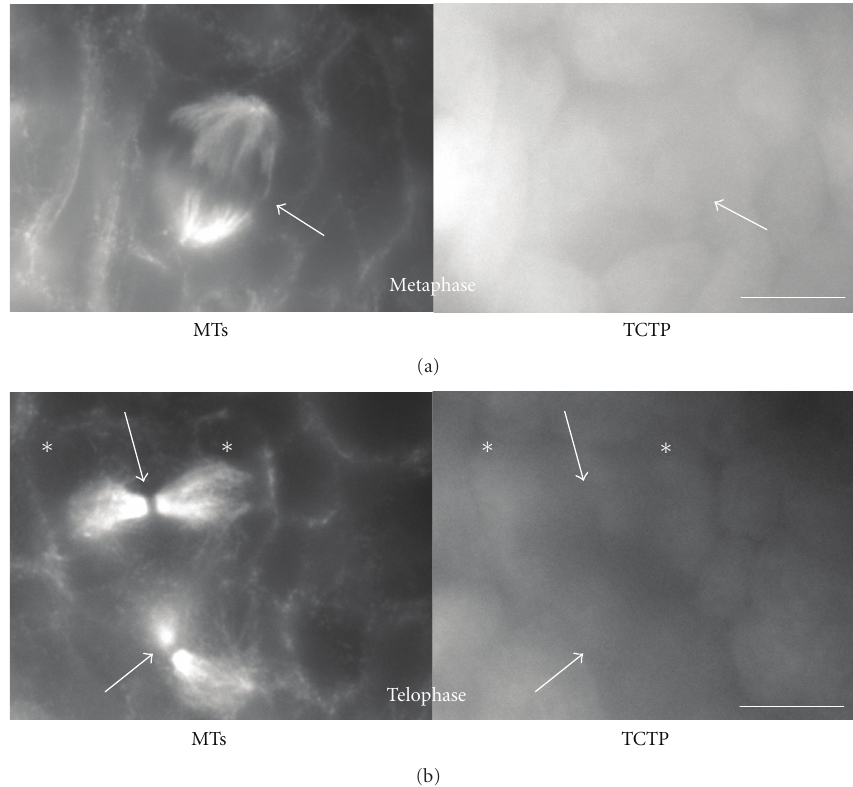
Figure 5: MTs and TCTP in mitotic Xenopus laevis oogonia. Left: β -tubulin, right: TCTP localization in tadpole oogonia. Anti-XlTCTP was used for this localization. Upper panel: metaphase cell. Left: mitotic spindle visualized by β -tubulin staining (white arrow). Right: The whole of the spindle is positive for TCTP (white arrow). Bottom panel: two telophase oogonia. Left: prominent midbides are visualized by anti- β -tubulin immunoflorescence (white arrows). White asterisks show the position of two daughter cells. Note the absence of TCTP in the midbodies. Bar is equal to 20 μ